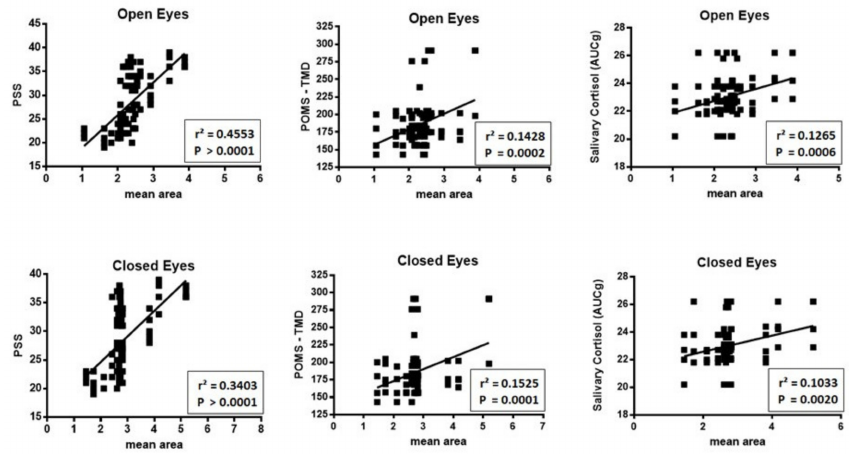
Figure 4. Relationship between scores, for each participant, of PSS, TMD and salivary cortisol with the mean value of A95 assessed in the five positions with open and close eyes. As can be seen, a significant correlation was observed for salivary cortisol, POMS and PSS with both open and closed eyes.